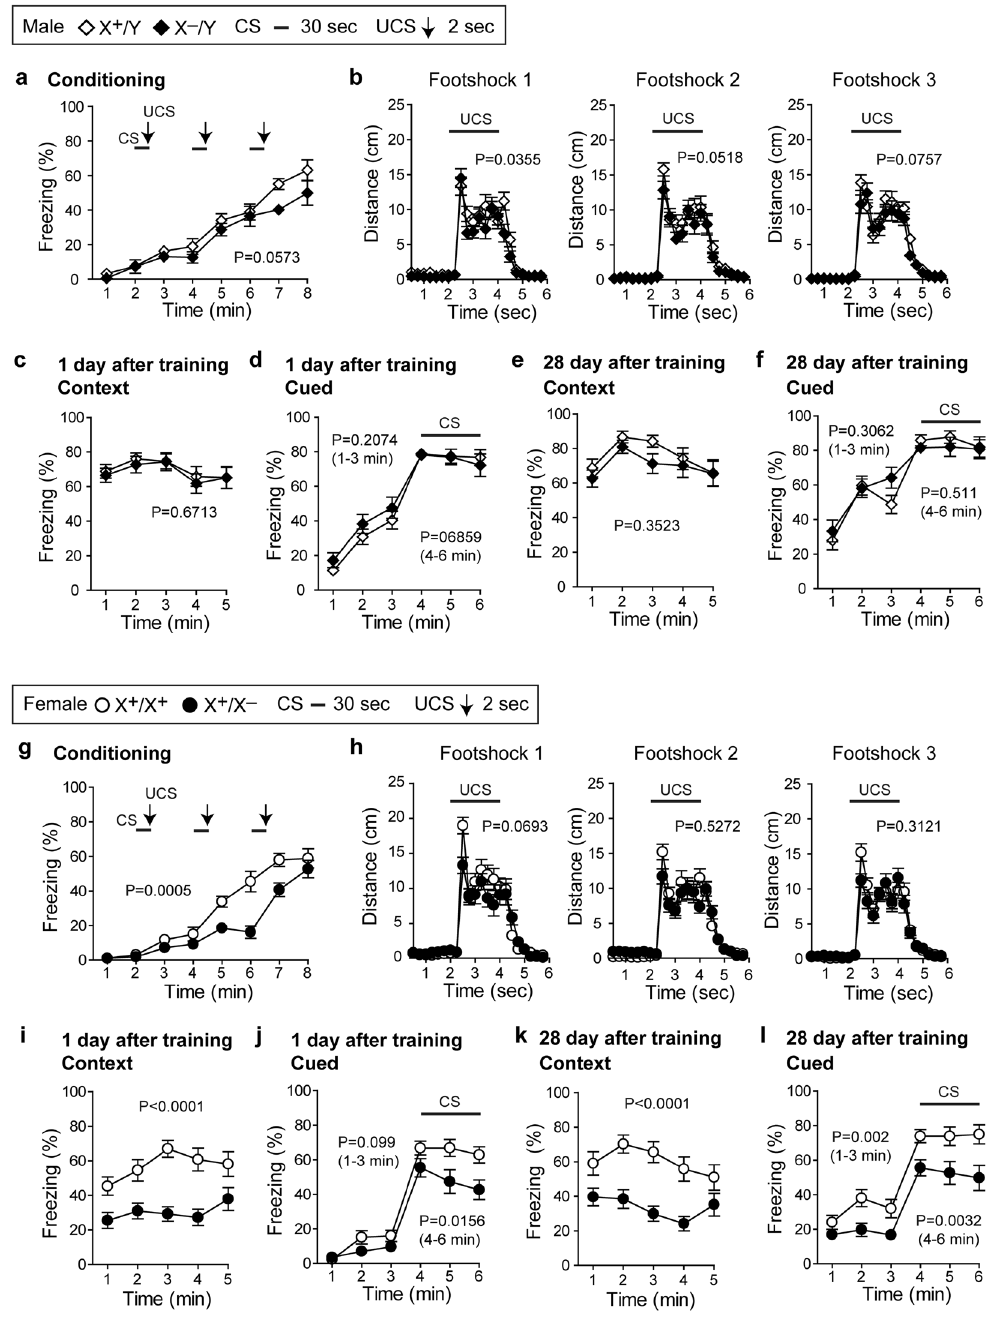
Figure 7. Pcdh19 hemizygous male and heterozygous female mutants show differential fear responses. Fear conditioning tests with male ( a – f ) and female ( g – l ) mice. For fear conditioning, a cue signal (CS) of 30 sec followed by 2-sec unconditioned stimulus (UCS, foot shock) was applied at 2, 4 and 6 mins after starting the test. ( a , b , g , h ) In both wild-type and Pcdh19 mutant males, the extent of freezing ( a ) and travel distance ( b ) induced by unconditioned stimuli (three footshocks) was increased. ( c , d ) Context-dependent ( c ) and cued ( d ) fear responses did not differ between wild-type and Pcdh19 hemizygous mutant males. ( e , f ) Retention test held 28 days after the training for contextual ( e ) and cued ( f ) fear responses in male mice. There were no significant differences between wild-type and Pcdh19 hemizygous mutant males. ( g , h ) In both wild-type and Pcdh19 heterozygous mutant females, the extent of freezing ( g ) and travel distance ( h ) induced by unconditioned stimuli (three footshocks) was increased, but with a significantly reduced freezing response in the mutants. ( i , j ) Contextual ( i ) and cued ( j ) fear responses significantly decreased in Pcdh19 heterozygous mutant females. ( k , l ) Retention test held 28 days after the training for contextual ( k ) and cued ( l ) fear responses. There was a significant decrease in both responses in Pcdh19 heterozygous mutant females compared to wild-type mice. In the experiments in ( c and i ), mice were put in the same box as used for the conditioning, whereas in ( d and j ), mice were put in a box different from the one used for the conditioning. The cue signal was applied at 4 mins after starting the test and lasted for 2